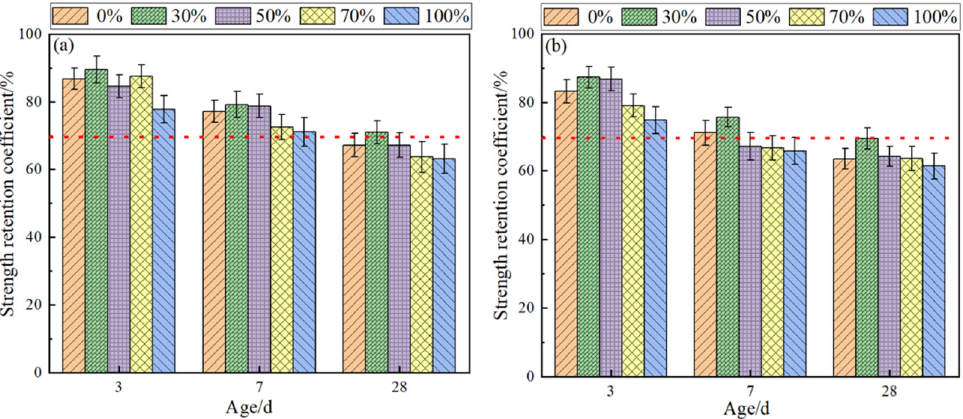
Figure 4. The softening coefficient of cement with different mass fractions of MgSO 4 ( a ): 6:1:15; ( b ):